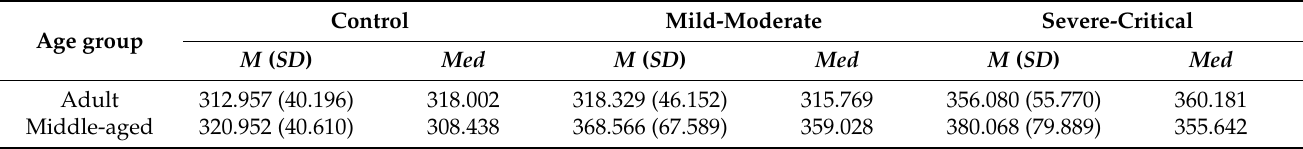
Table 7. Reaction times by age subgroups (presented values are in